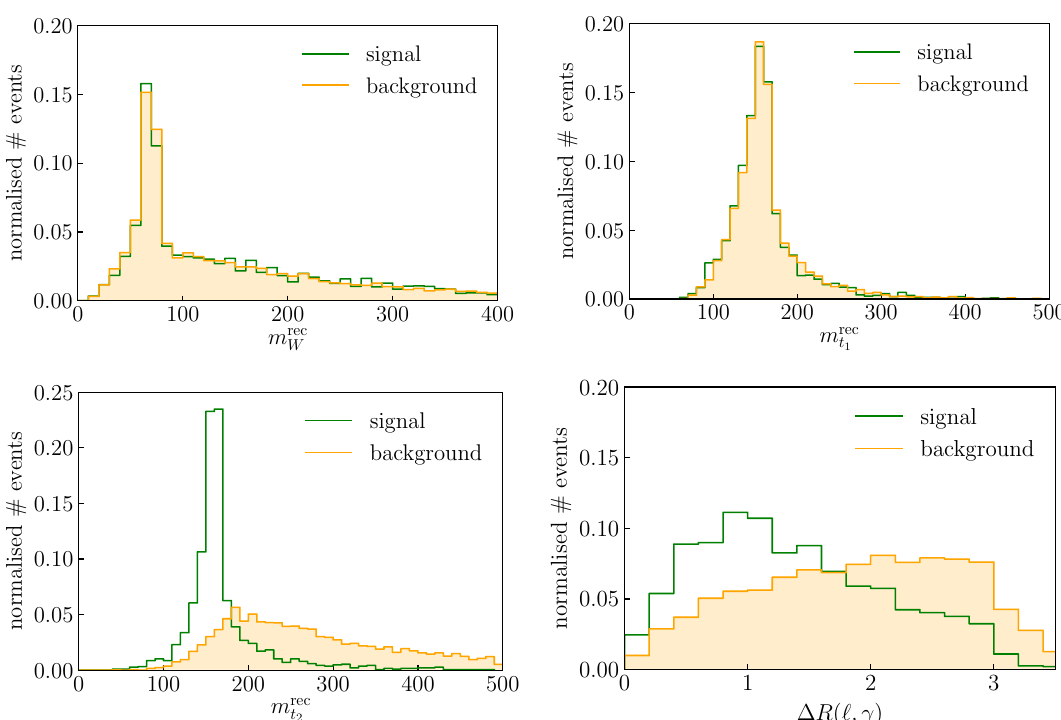
m rec t . Bottom right: angular separation between the lepton and the pho- 1 ton after the cut on m rec t . In all cases, the signal (background) appears 1 . Bot- in green W